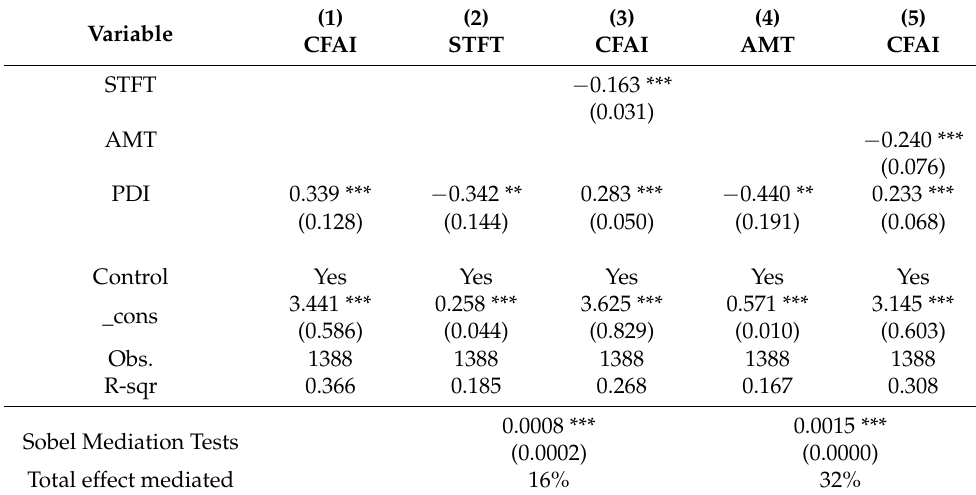
Table 6. Effects of PDI on CFAI mediated by STFT and AMT